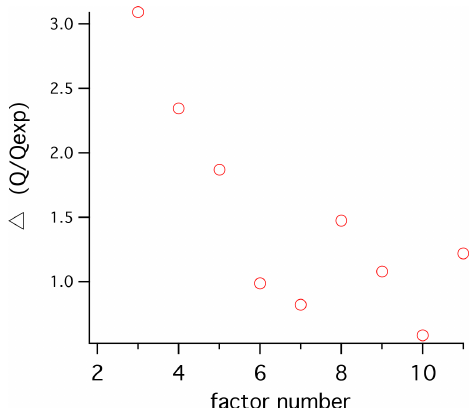
Figure 2. Change in the goodness-of-fit parameter Q to Q expected as a result of increasing to a given factor number. Relatively strong improvements are seen for changes up to five factors, with additions to six and seven factors showing much smaller improvement. Above five factors the ratio is variable and improvement is